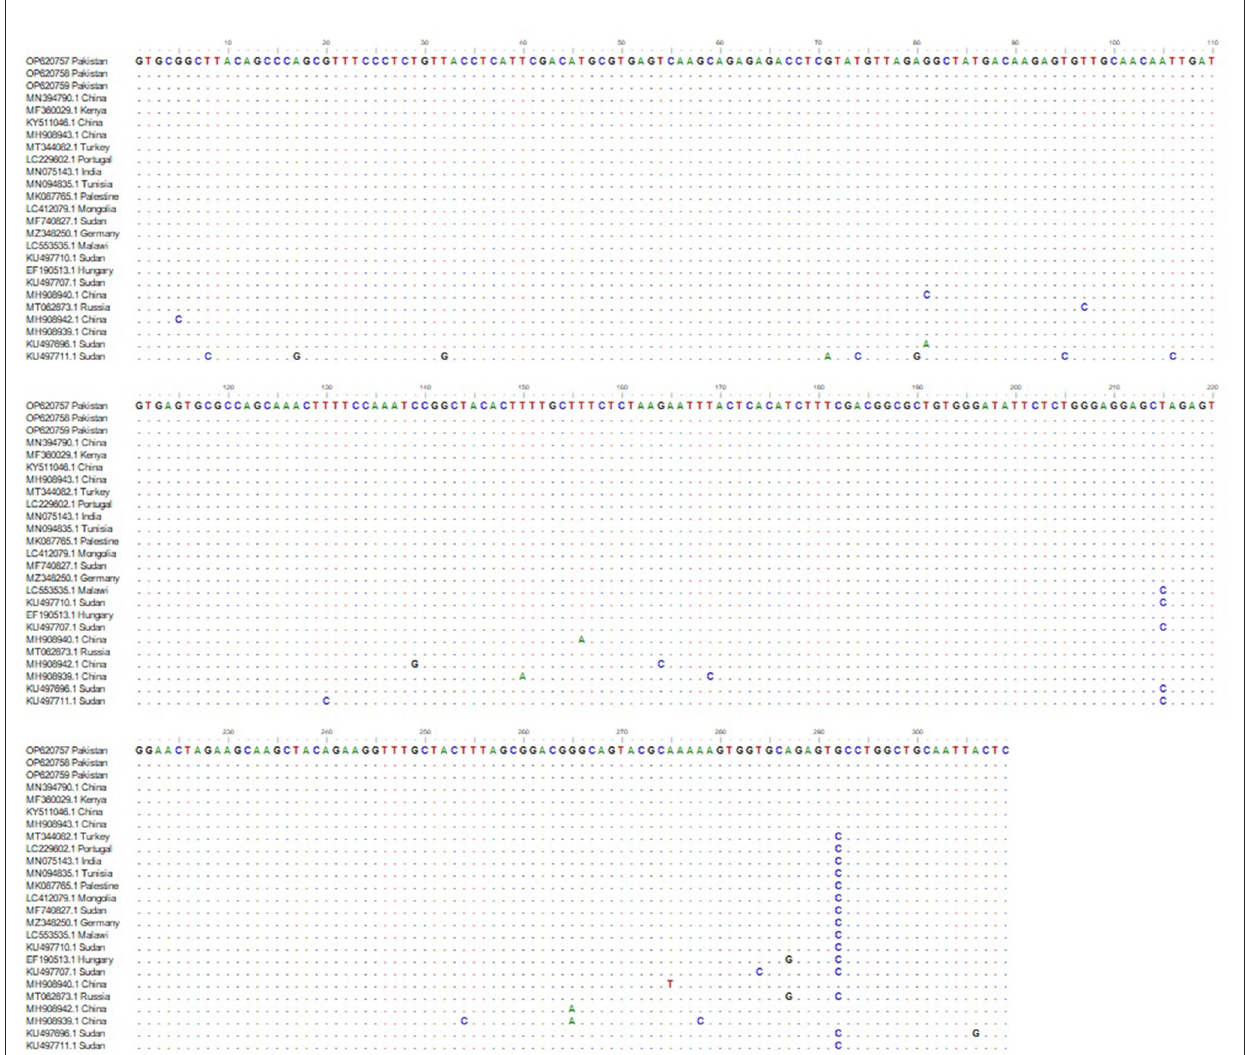
FIGURE1 Phylogenetic analysis of Anaplasma ovis based on msp4 partial gene sequence. Sequences in the box were determined in this study. GeneBank accession numbers and country are shown for all sequences. Values at the nodes represent the number of occurrences of clades in 1,000 bootstrap replications of the taxa. The msp4 partial gene sequence of Anaplasma marginale from Mexico, Anaplasma centrale from Israel were and Anaplasma phagocytophilum from Italy were used as the outgroup. Maximum Likelihood method and Kimura 2-parameter model were used to infer the evolutionary history. The tree with the highest log likelihood ( − 1,168.91) is shown. Evolutionary analyses were conducted in MEGA11.